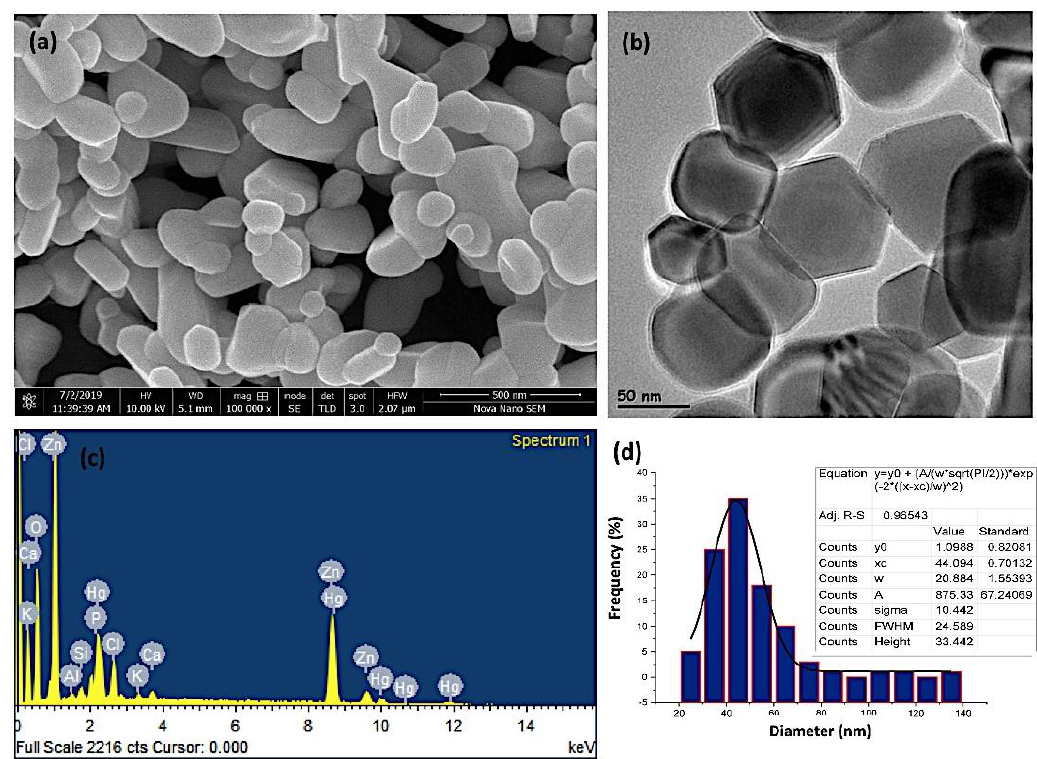
Figure 2. ( a ) Scanning electron microscopy (SEM) images, ( b ) high-resolution transmission electron microscopy (TEM) image, ( c ) EDAX (energy dispersive X-ray analysis) semi-quantitate compositional analusis, and ( d ) the particle size distribution of the investigated ZnO-NPs.